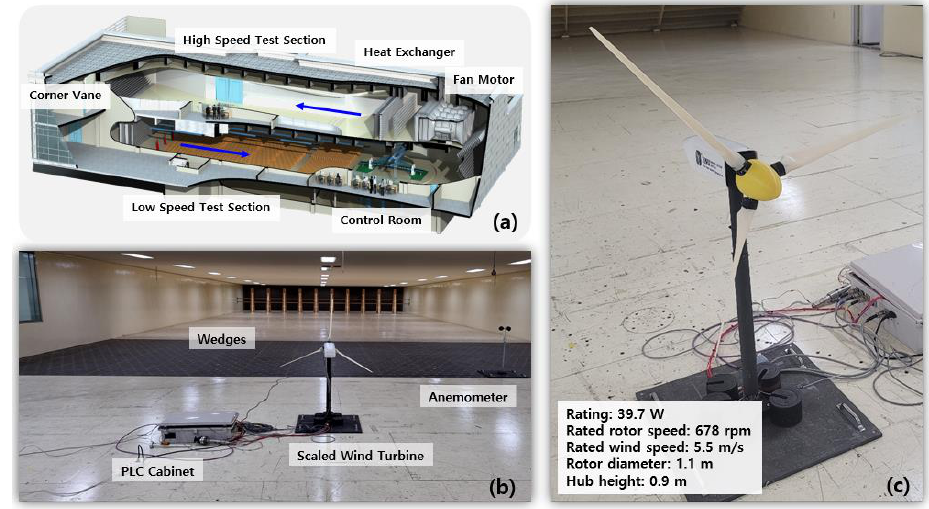
Figure 8. Wind tunnel testing environment: ( a ) overall wind tunnel setup; ( b ) low-speed test section; ( c ) scaled wind turbine model that was capable of pitch control and torque control.